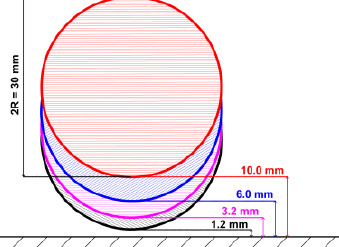
Fig. 3b: Schematic visualization of Setup II: different stand-off distances